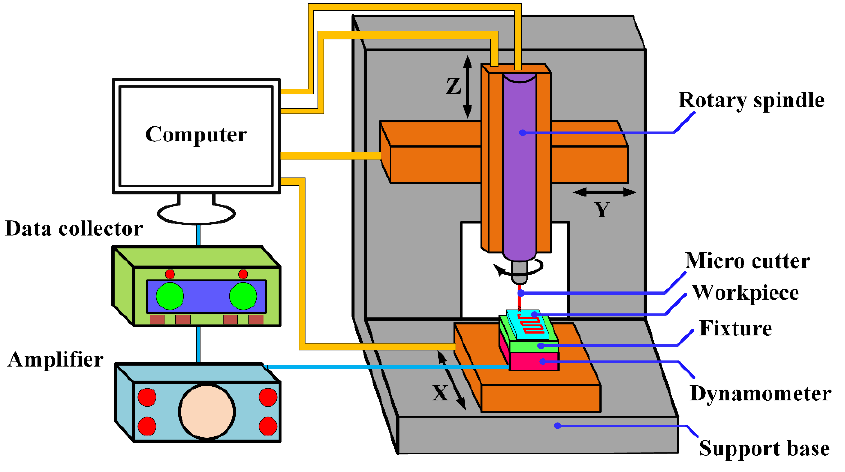
Figure 5. Schematic illustration of the machine device.